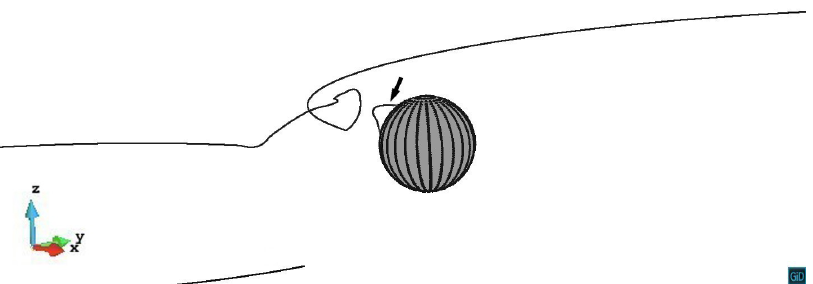
Figure 11. The dislocation line in z / R = − 0.2 case bypassing the precipitate with a prismatic loop (black arrow) left. The plastic strain ε = 2.31 × 10 − 4